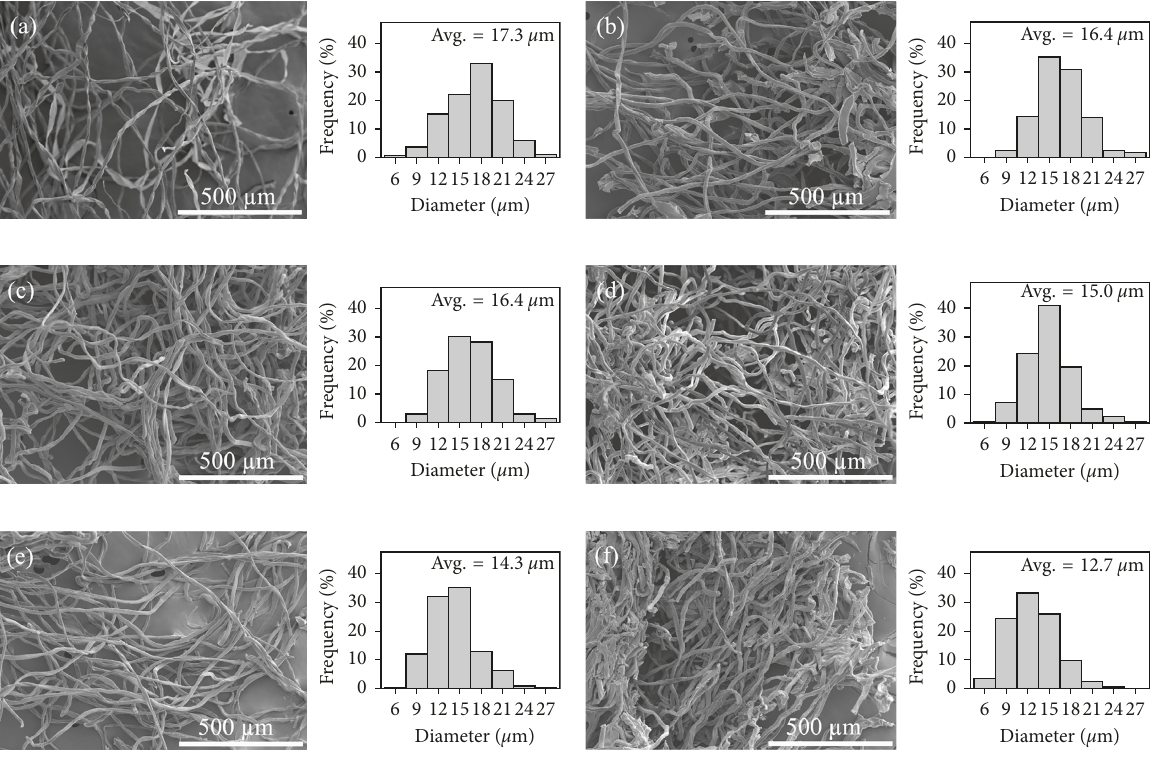
Figure 10: SEM images of (a) natural cotton linter and oxidized natural cotton linter for (b) F1, (c) F2, (d) F3, (e) F4, and (f) F5 and their diameter size distribution.